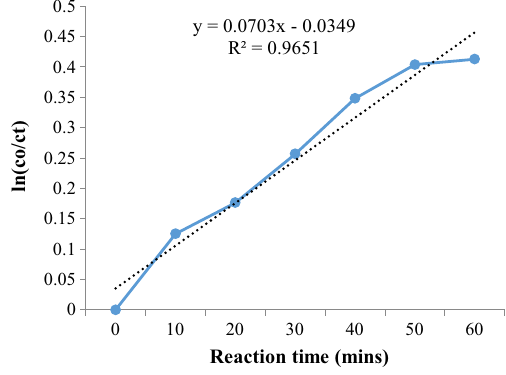
Fig. 9 Kinetics of C.O.D. removal in electro oxidation after coagula- tion and fenton